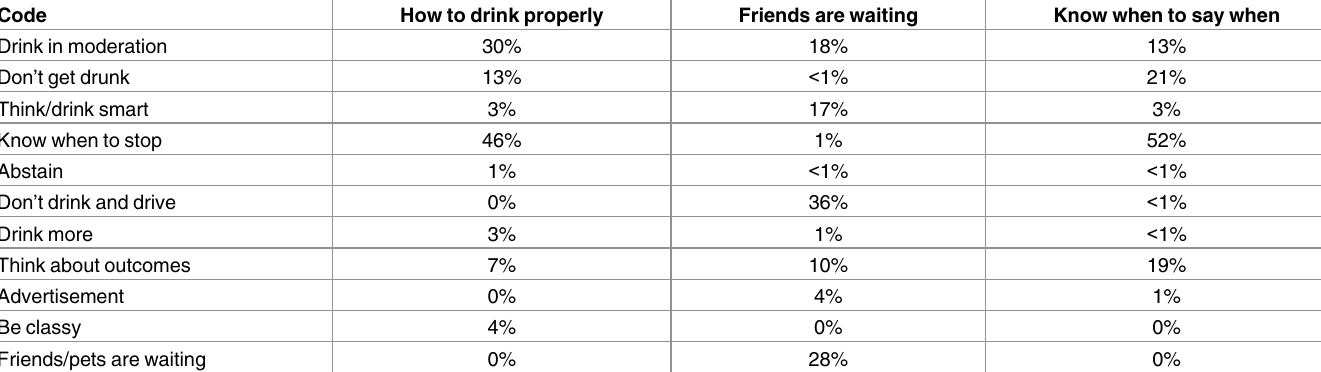
Table 4. Perceived main messages (grouped) for adult-targeted ads (Study Two, n =